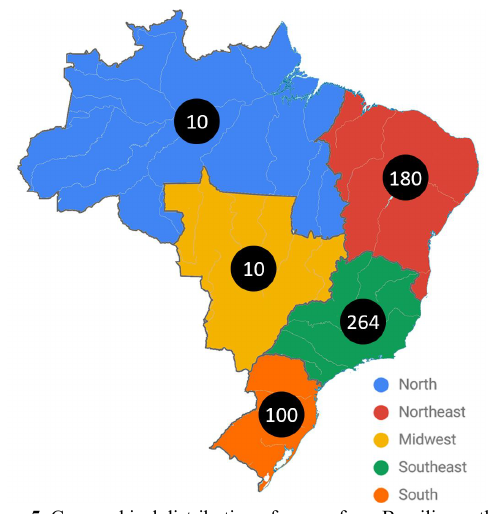
Figure 5. Geographical distribution of papers from Brazilian authors.